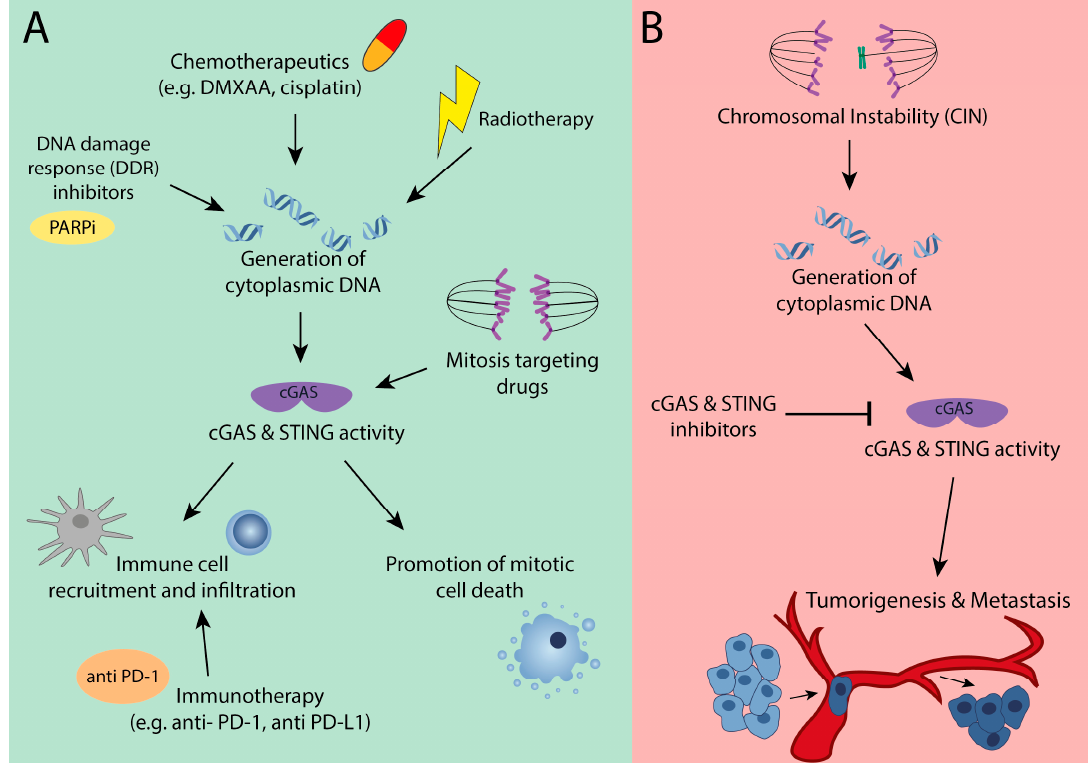
Figure 4. Context dependent cancer therapeutic strategies when targeting cGAS or STING. ( A ) Targeting the tumor suppressor role of cGAS-STING through activation of cGAS-STING signaling by different means to generate cytoplasmic DNA (radiotherapy, chemotherapy, DNA damage response (DDR) inhibitors, and others) promotes immune cell infiltration into tumors and cell death in mitosis. ( B ) Targeting the oncogenic role of cGAS-STING signaling through cGAS or STING chemical inhibitors could delay tumor progression and suppress metastasis.